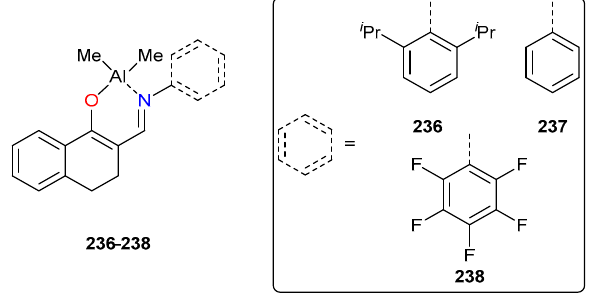
Figure 38. Cyclic β -ketiminato aluminum complexes 236–238 [115].